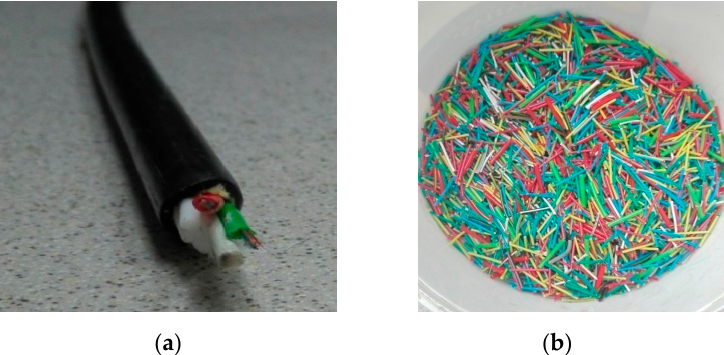
Figure 1. Optical fiber: ( a ) fiber optic cable; ( b ) POFs from e-waste, with lengths of 15–20 mm and diameter of 1 mm. Table 2. Chemical composition of cement CEM I 42.5R (%).